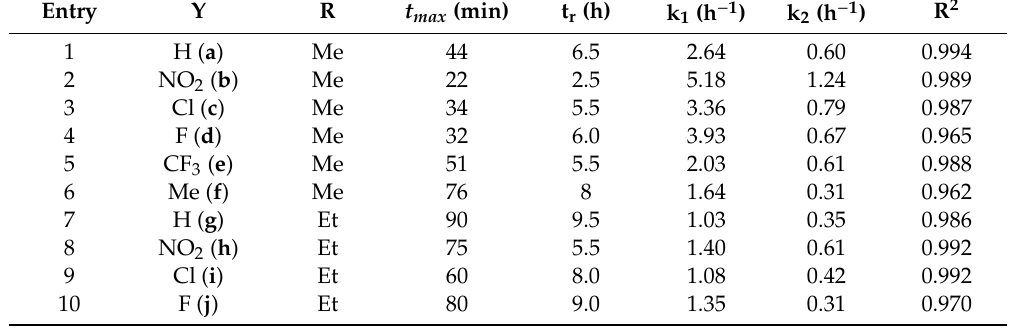
Figure 1. Concentration profile for the components during the hydrolysis of dimethyl α -hydroxybenzylphosphonate ( 1a ) under optimum conditions. The R 2 measure of goodness of fit is 0.994.